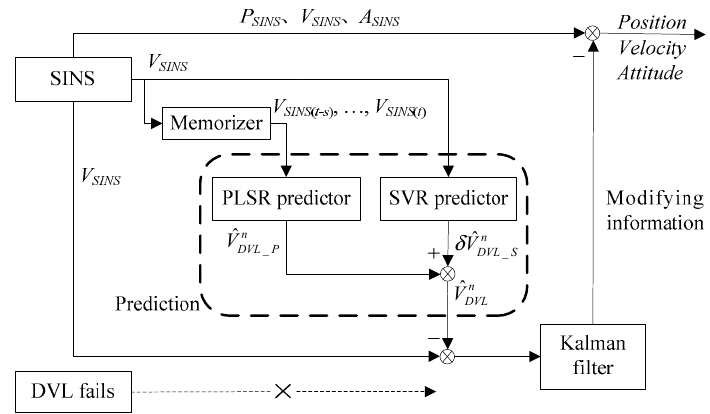
Figure 5. The block diagram of prediction mode.